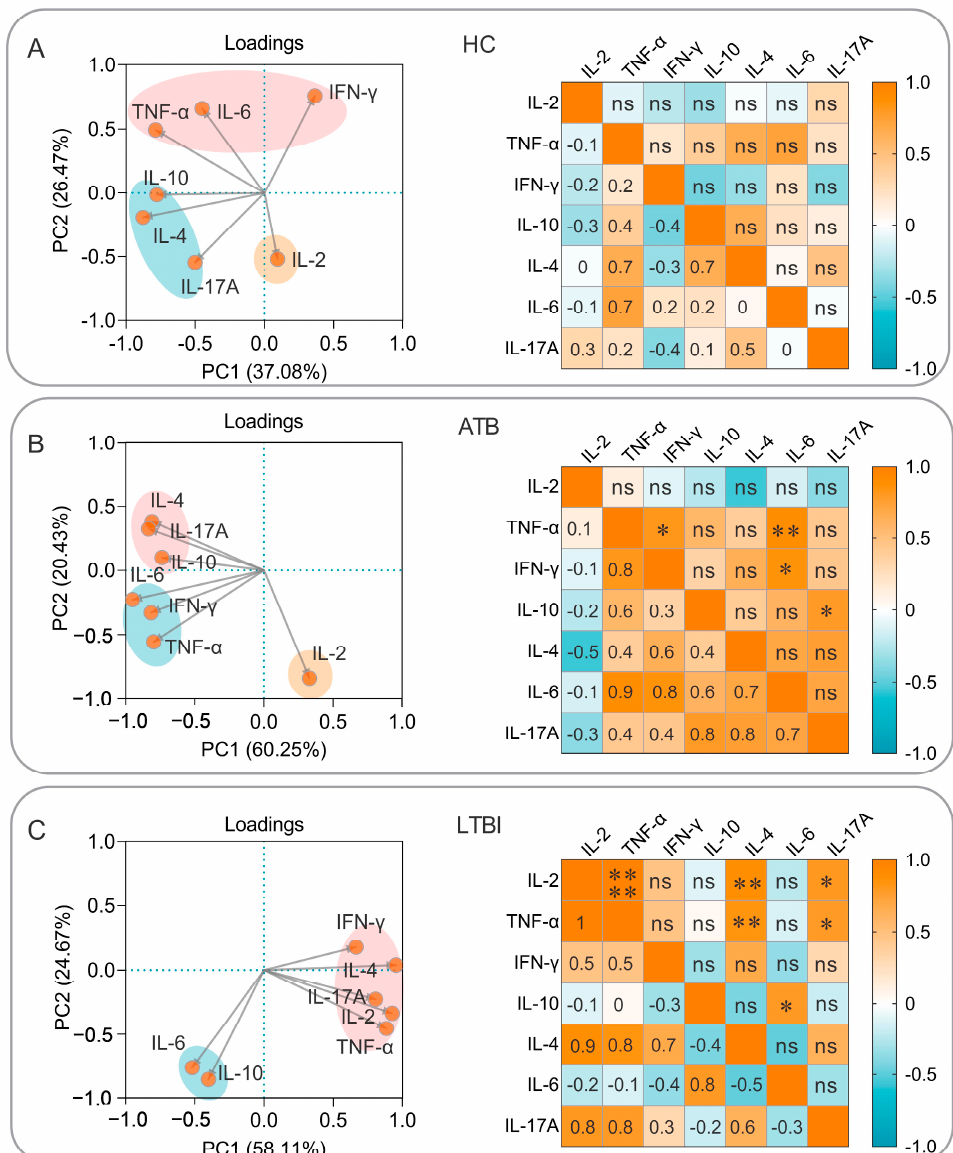
Figure 11. Principal component analysis (PCA) and correlation analysis. The purified PP19128R vaccine was used to stimulate PBMCs obtained from HCs ( A ), ATB patients ( B ), and individuals with LTBI ( C ). PCA and correlation analysis were performed to analyze the potential effects among cytokines using GraphPad Prism 9.5.1 software. The PCA analysis selected PCs with eigenvalues greater than 1.0 (“Kaiser rule”) as the component selection method. The proportions of variance for PC1 and PC2 are plotted on the x-axis and y-axis, respectively. The correlation analysis used Pearson’s R to determine the relationship between two cytokines, and R values of − 1 to 1 are shown in blue to orange, respectively. *, p < 0.05, **, p < 0.01, ****, p < 0.0001; ns, no significant